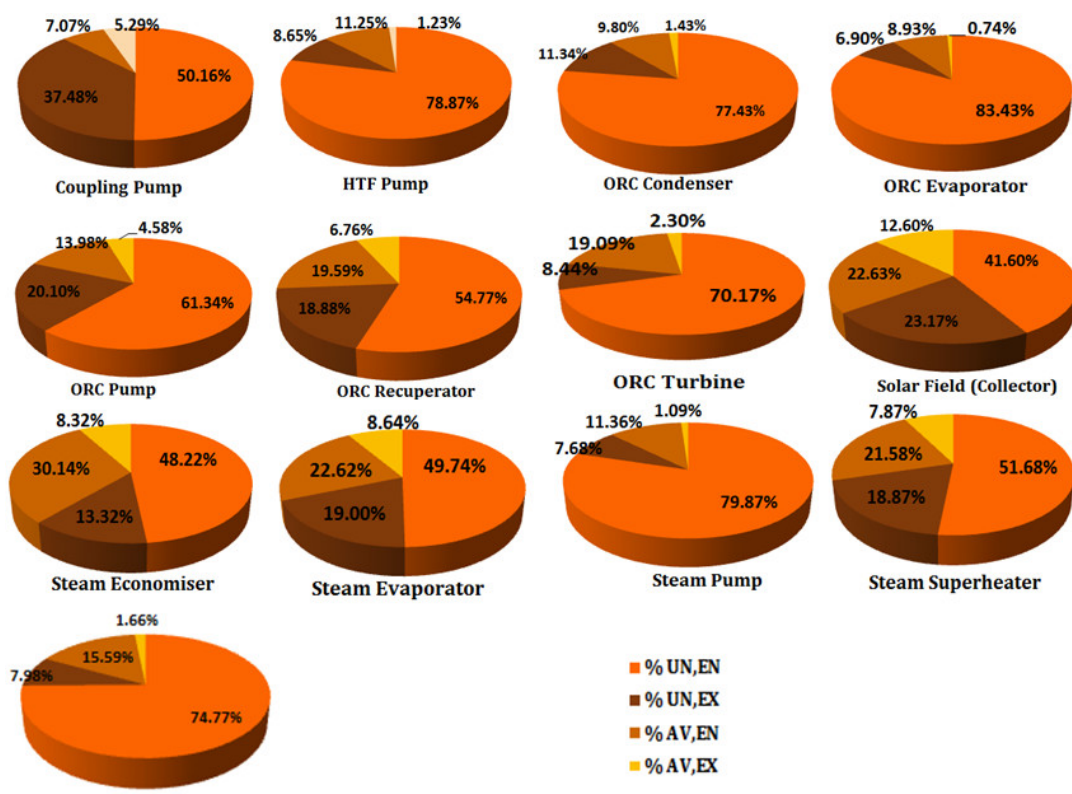
Figure 6. Advanced exergo-economic destruction rate of each component in the solar–geothermal cycle (SGPP).